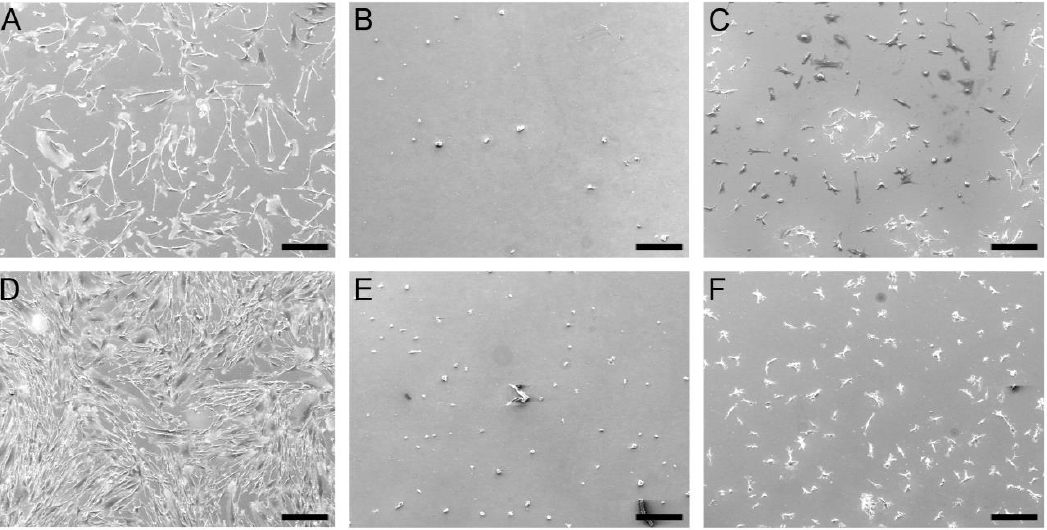
Figure 10. Scanning electron microscopy images of HGFIBs cultured on uncoated Ti-6Al-4V ( A , D ), Alg/PLL coated Ti-6Al-4V ( B , E ) and Alg/NITEGE coated Ti-6Al-4V ( C , F ) after 24 h ( A – C ) and 72 h ( D – F ). Scale bar = 200 µm.